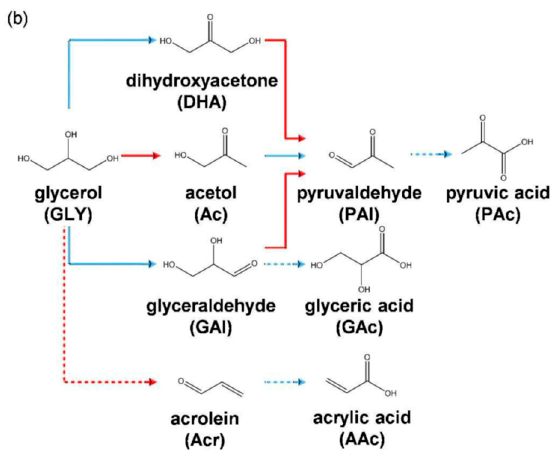
Figure 14. Reaction network envisaged for the gas-phase conversion of glycerol to pyruvaldehyde. The dashed arrows identify competitive oxidative and dehydrative pathways. Reprinted with permission from reference [113]. Copyright 2016 Royal Society of Chemistry.